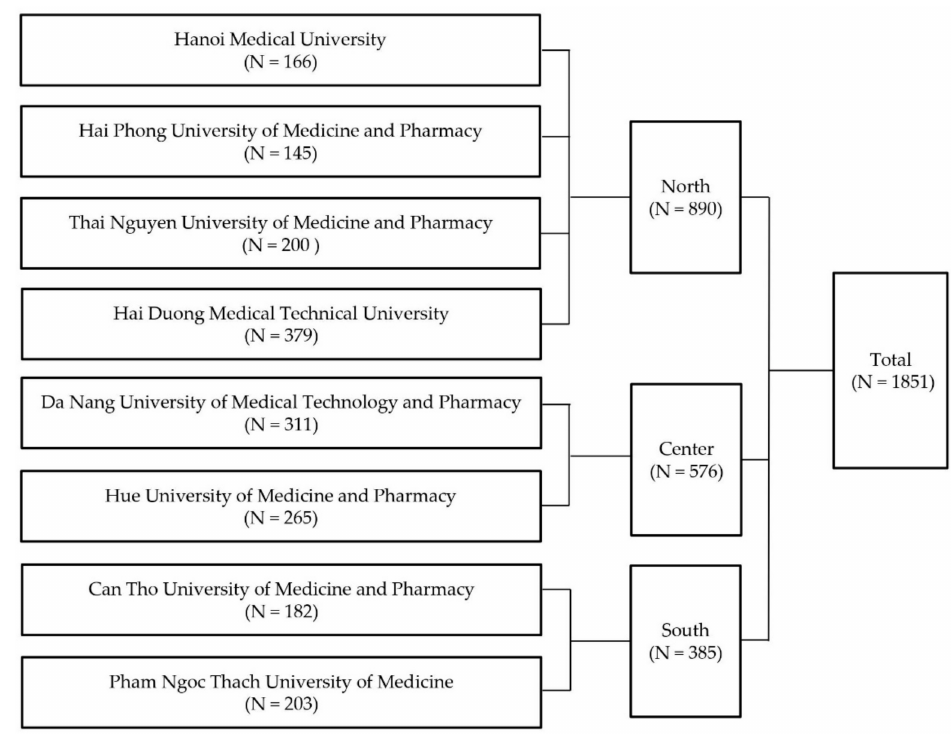
Figure 1. The study sample in different